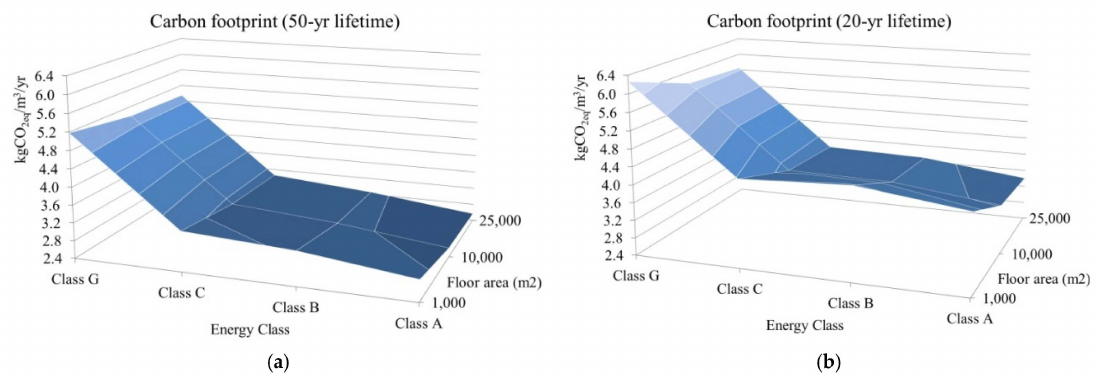
Figure 11. CF as a function of floor area and insulation level under reference hypotheses. Results (kgCO 2 eq /m 3 /year) are shown for 50-year lifetime ( a ) and 20-year lifetime ( b ).